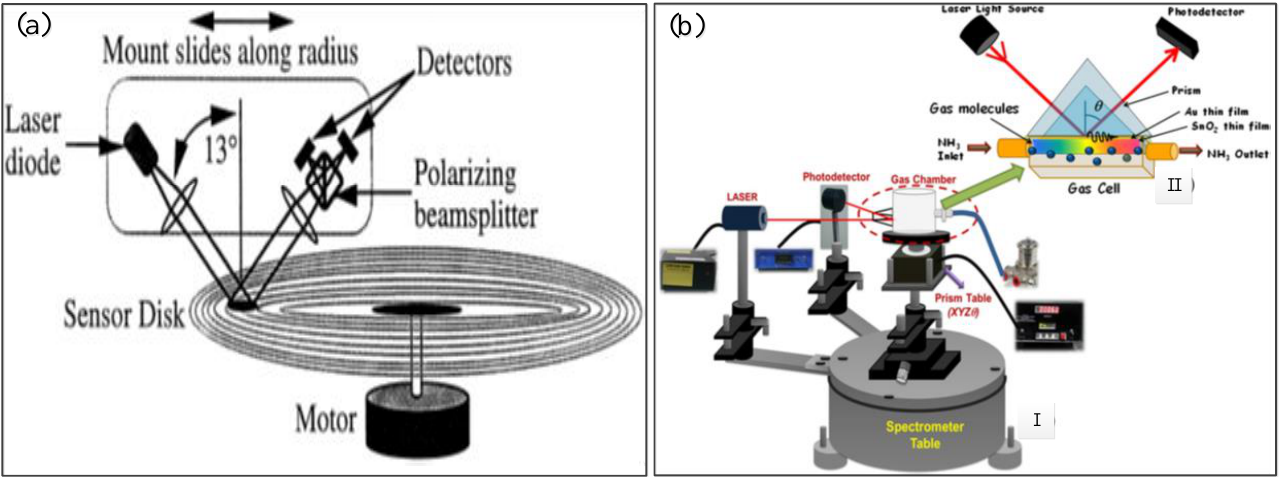
Figure 11. ( a ) Design of the sensor disk optical system. Reprinted from [114] with permission from Elsevier; ( b ) (I) Schematic of the SnO 2 /Polypyrrole based SPR gas sensor; and (II) Kretschmann configuration utilized for ammonia gas detection. Figure adapted from [116].